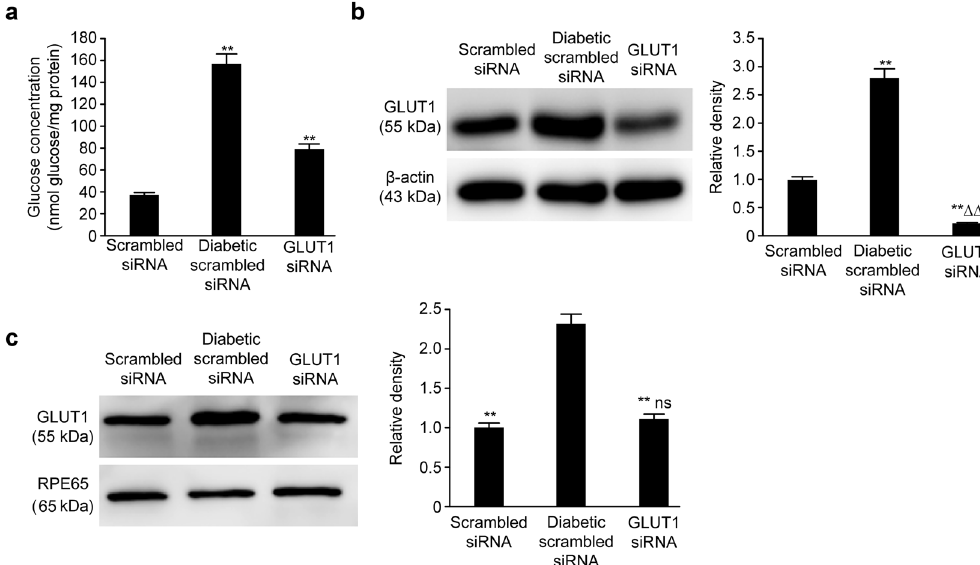
Figure 1. ( a ) Determination of glucose concentration in retinal tissues of the three groups, ** P < 0.01 vs. scrambled siRNA group, n = 6, x ± S. ( b ) GLUT1 expression in the neural retinal layers of the three groups, ** P < 0.01 vs. scrambled siRNA group, ΔΔ P < 0.01 vs. diabetic scrambled siRNA group, n = 6, x ± S. ( c ) GLUT1 expression in the retinal pigment epithelia of the three groups, ** P < 0.01 vs. diabetic scrambled siRNA group, ns: P > 0.05 vs. scrambled siRNA group, n = 6, x ± S. Full-length blots are presented in Supplementary Figure